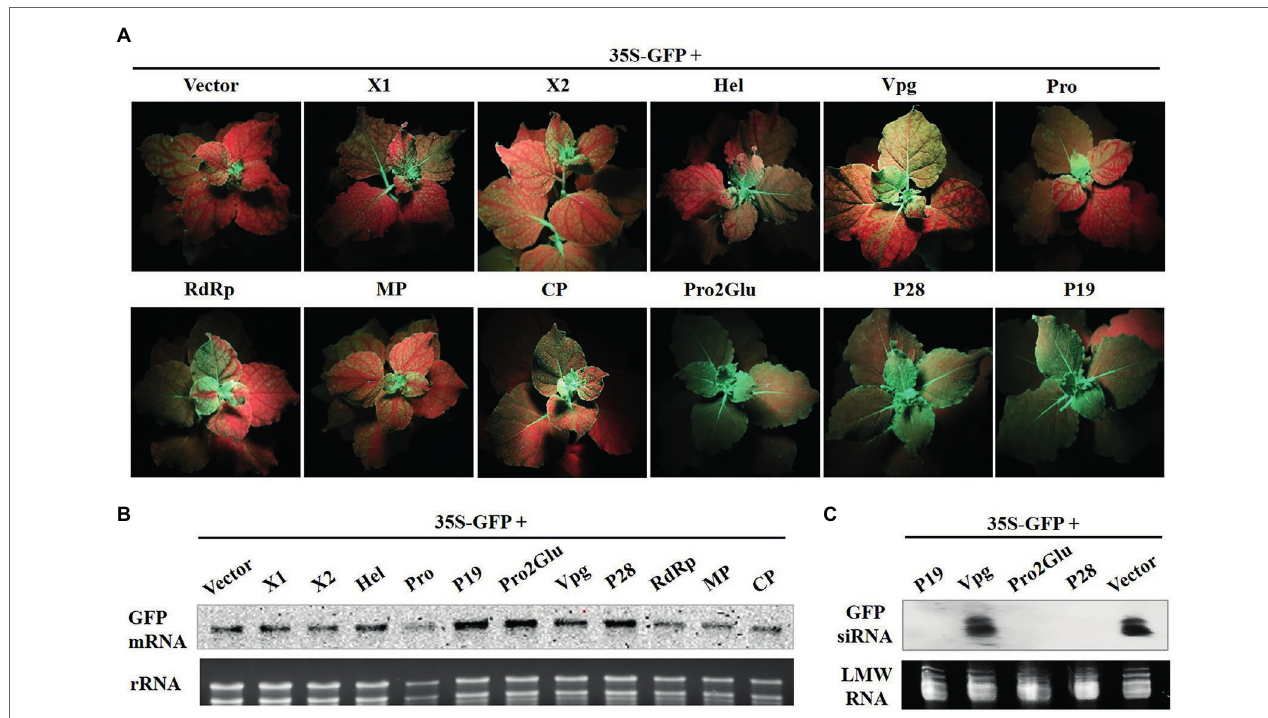
FIGURE 3 | Pro2Glu and P28 inhibited the systemic silencing of GFP in N. benthamiana line 16c plants. (A) N. benthamiana 16c plants infiltrated with 35S-GFP and recombinant plasmids were photographed under UV light at 28 dpi. (B) The analysis of GFP mRNA in upper young leaves by Northern blot at 28 dpi. (C) The analysis of GFP-specific siRNAs in upper young leaves by Northern blot at 28